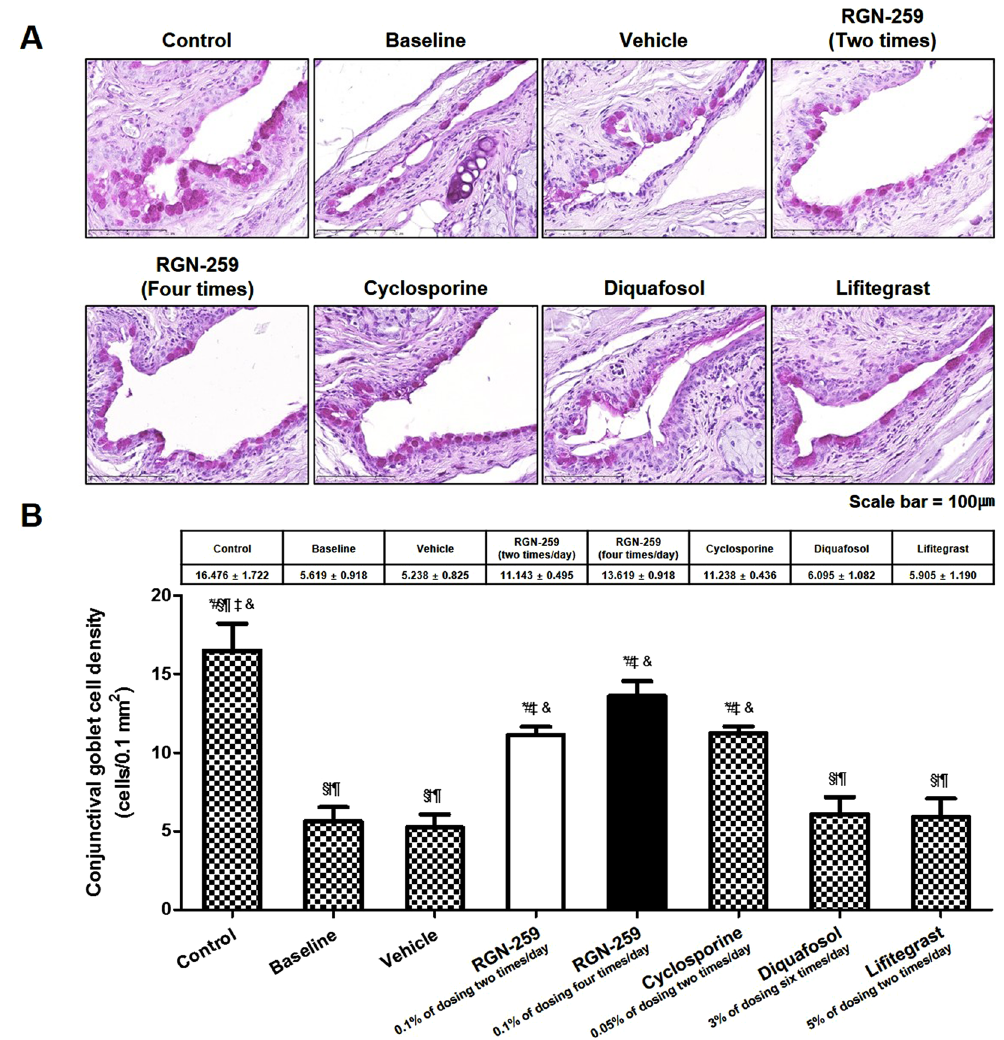
Figure 5. RGN-259 increased conjunctival goblet cell densities comparable to that of CsA. ( A ) Periodic acid Schiff staining. The strong violet color indicates the conjunctival goblet cells. Scale bar = 100 μ m. ( B ) The number of conjunctival goblet cells. * P < 0.05 vs. the corresponding value in the baseline desiccation stressed group. # P < 0.05 vs. the value in the vehicle-treated group. § P < 0.05 vs. the value in the RGN-259, 2 times per day group. † P < 0.05 vs. the value in the RGN-259, 4 times per day group. ¶ P < 0.05 vs. the value in the CsA group. ‡ P < 0.05 vs. the value in the DQS group. & P < 0.05 vs. the value in the LFA